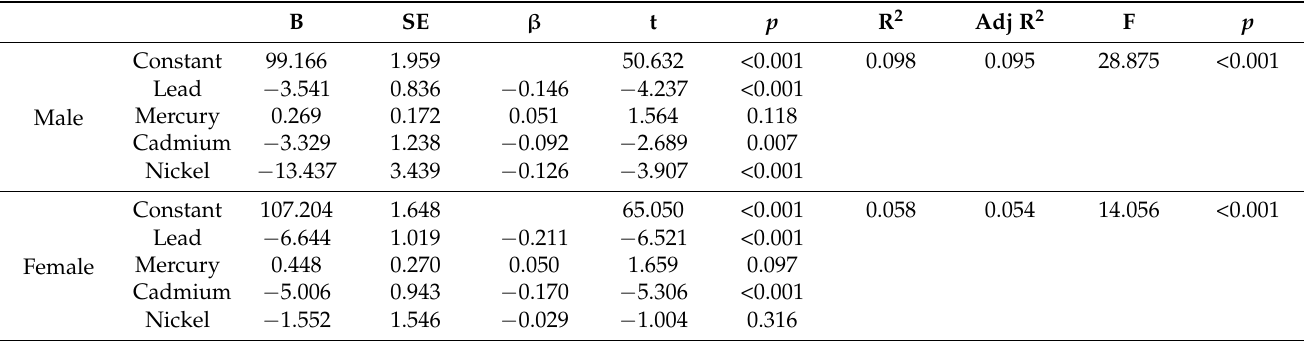
Table 5. Effects of blood lead, mercury, nickel, and cadmium on